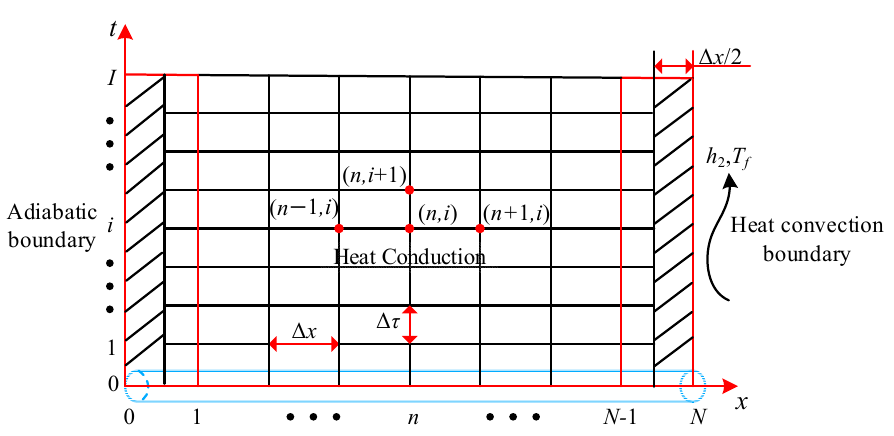
Figure 5. Schematic diagram of the “time-space” dispersion of the screw shaft.